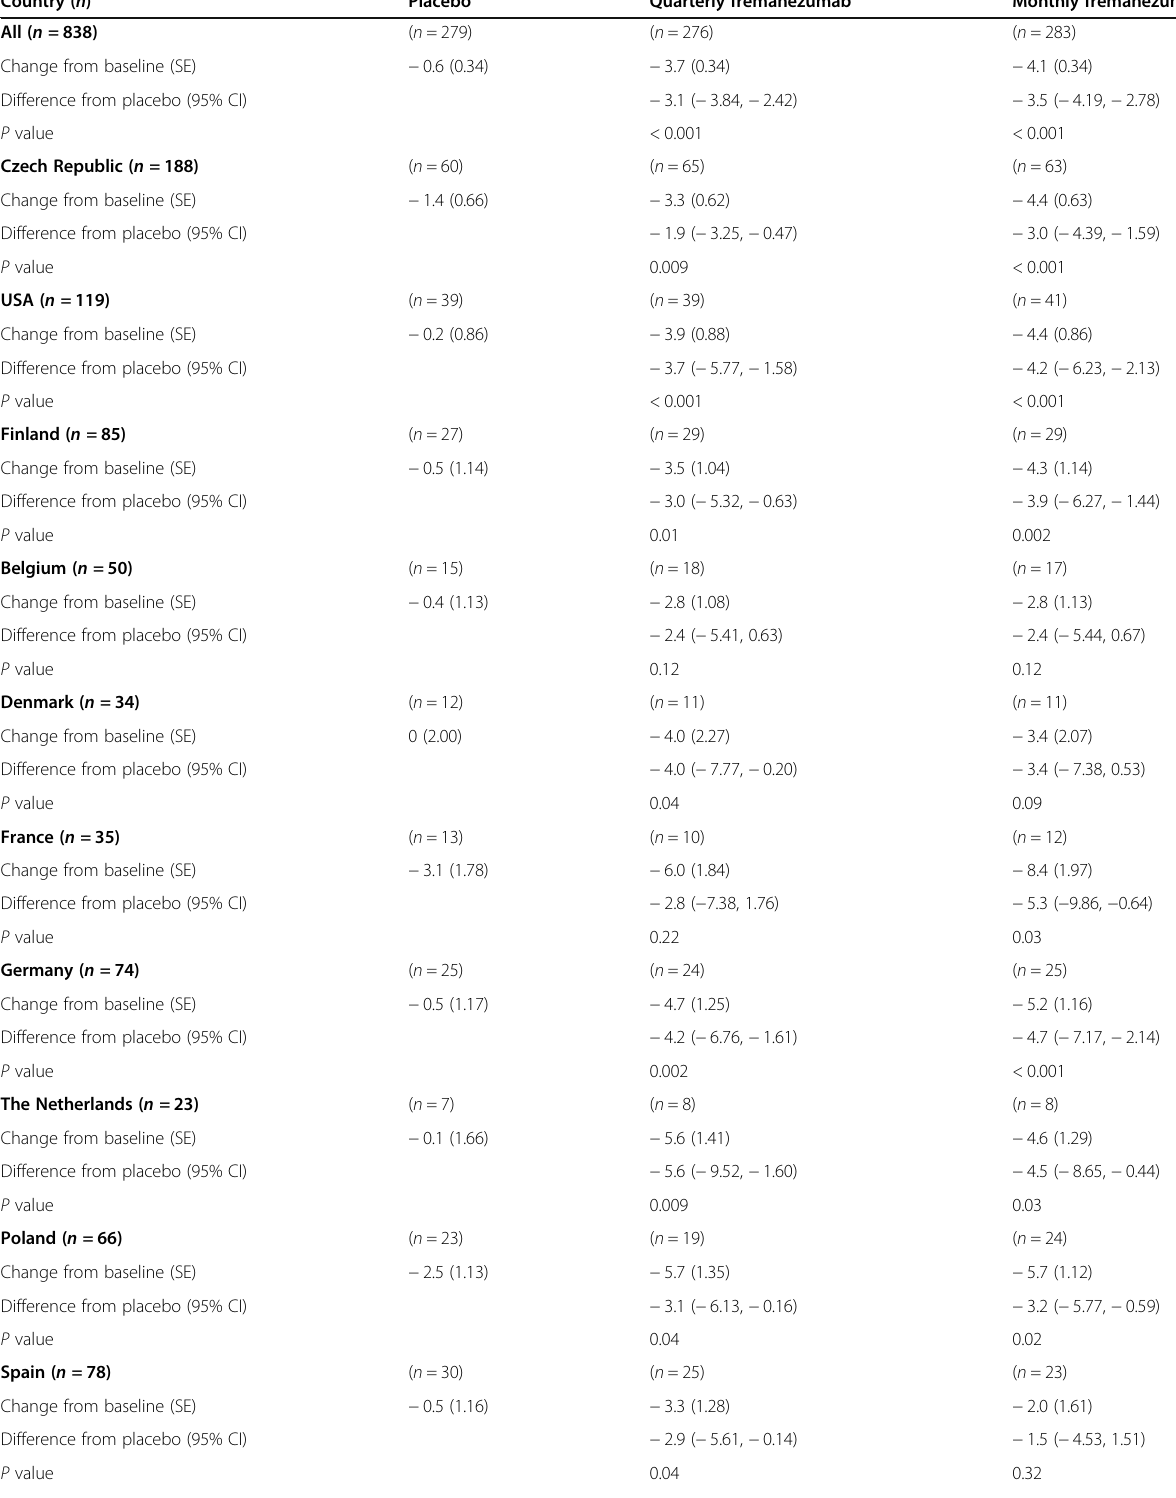
Table 1 Change From Baseline in the Monthly Average Number of Migraine Days During 12 Weeks of Double-blind Treatment (Primary Efficacy) in Individual Countries and Overall